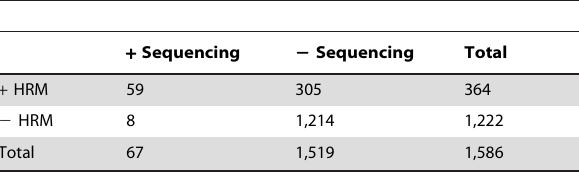
Figure S1 Representation of HRM curve of BRAF exon 15 from genomic DNA extracted from frozen samples. Red arrow: HRM curves with a plot interpreted by the software to be suspicious of harboring a nucleotide change or a mutation/variant. HRM was repeated for all these samples, and all of them were sequenced. Green arrows: HRM curves with minimal variations with respect to the averaged wild-type curve. All these samples also were sequenced and HRM was repeated. Black arrow: All normalized HRM curves considered to have a wild-type sequence. 20% of these samples were randomly chosen to be repeated and sequenced as negative controls. Figure S2 Example of HRM output from genomic DNA from tumor frozen samples set. A. Output of one of the 3 plates used for the initial analysis of exon 2 of KRAS . Each square represents a well: brown squares are negative controls; grey squares represent samples with no mutation/variant; red squares represent possible mutation/variant; and green are unknown for mutation/variant. B. Normalized HRM curve from the same samples in the exon 2 of KRAS initial analysis. C. Normalized HRM curve of the repeated KRAS analysis. Figure S3 Samples of mutation screening with HRM technology and its validation with sequencing from paraffin-embedded samples. A. One of the assays ( EGFR ) performed in paraffin- embedded samples from breast cancer: 1. Normalized HRM curves of the assay; 2. Segment of sample assembled trace after sequencing, with the presence of a variant, where AA has replaced both alleles GG. B. Endometrial paraffin-embedded samples for KRAS . 1. Normalized HRM curves of the assay with elevated number of positives samples observed in the HRM curves from paraffin specimens compare to frozen samples; 2. Genotype GG has been substituted by GA. Table S1 Mutation details from the sequencing analysis of paraffin-embedded samples.